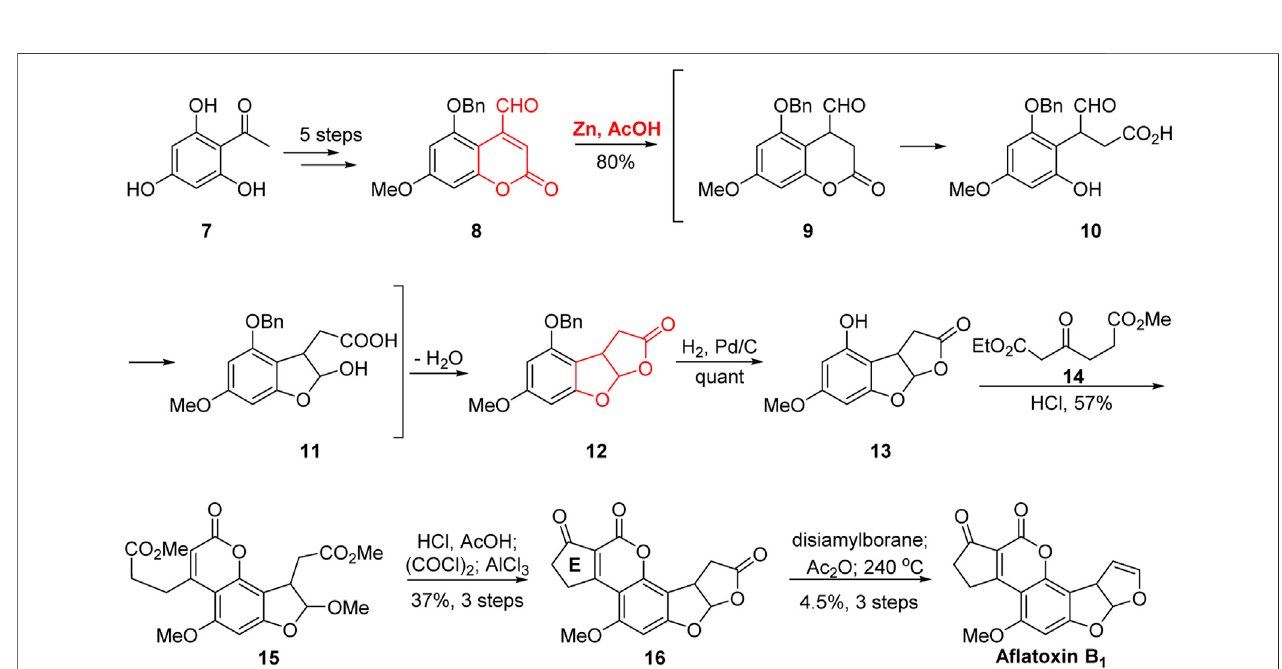
FIGURE 2 | First total synthesis of ( ± )-a fl atoxin B